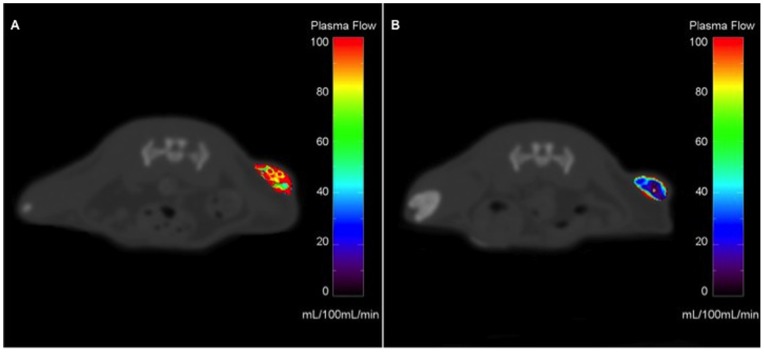
Representative color-coded maps for plasma flow (Fp) pre (A) and post therapy (B).Plasma Flow (Fp) values [mL/100 mL/min] are coded according to the vertical color scale. For demonstration purposes only and in contrast to the actual plasma flow assessment, pixel-wise analysis has been conducted here in order to create color-coded maps for a better visualization of the effects of regorafenib therapy. As their position relative to the tumor remains constant, vertebral bodies were used as topographic landmarks to assure analysis of comparable tumor slices. Note the adducted left lower limb in the post therapy image, which does not have an effect on tumor position. Before regorafenib therapy, we observed a highly perfused tumor with a hyperperfused rim (A). After regorafenib therapy, tumor perfusion has declined significantly, predominantly in the center of the tumor (B).